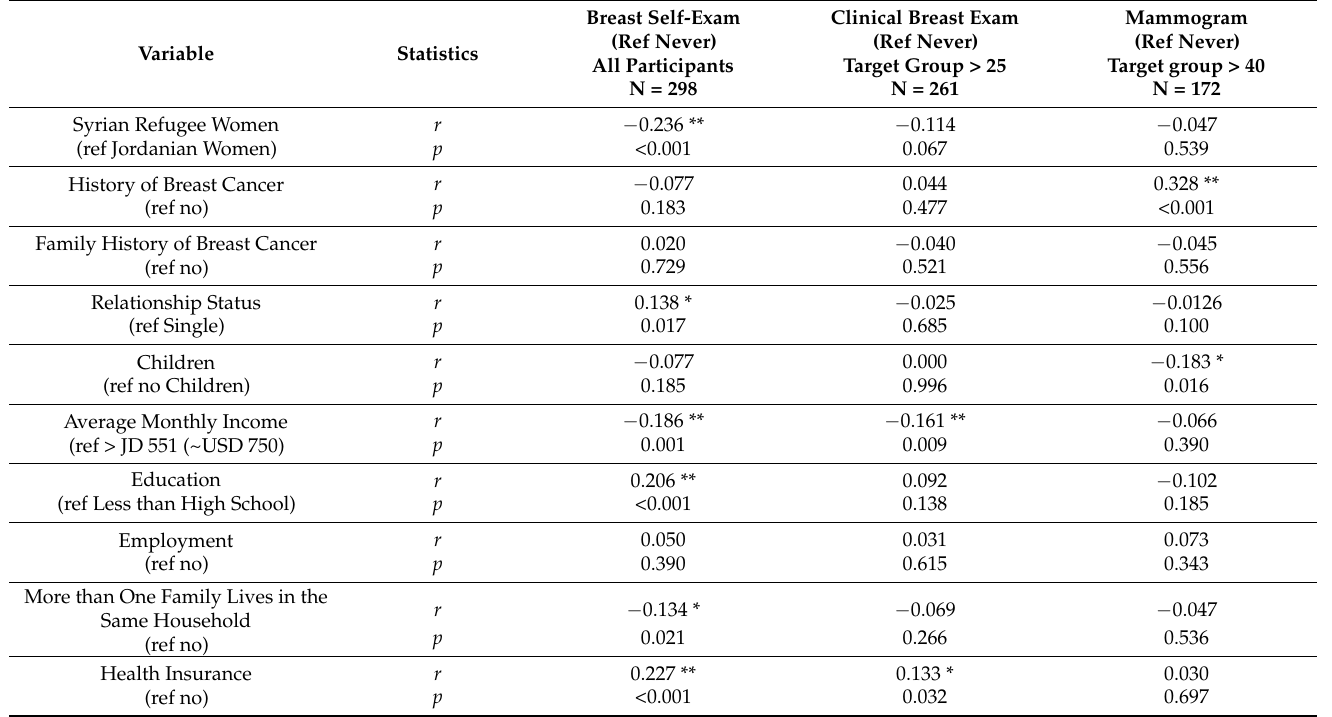
Table 3. Correlation analysis between breast cancer screening practices and participants’ sociodemo- graphic